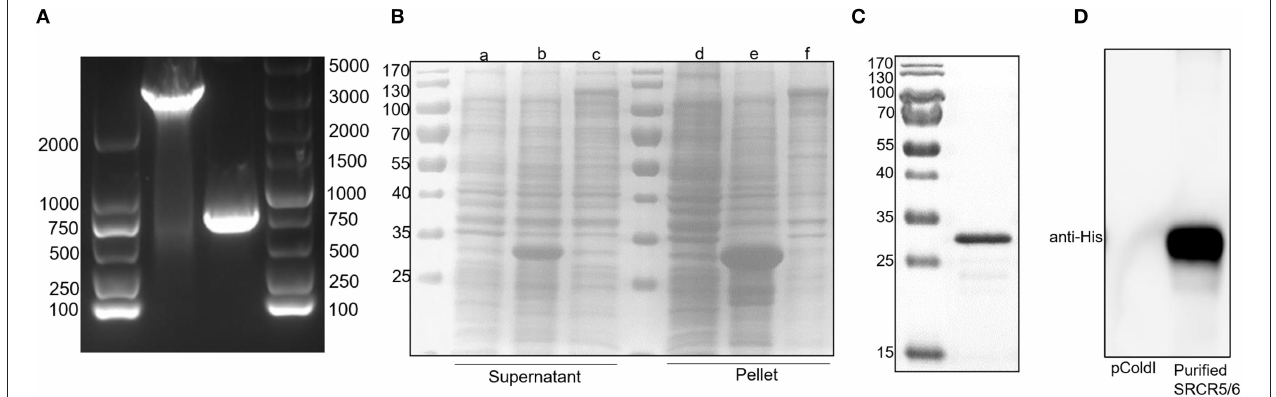
FIGURE 1 | Expression of His-tagged CD163 SRCR5-6 protein and its purification with SDS-PAGE. (A) Amplification of CD163 nucleotides 151-3348 and CD163 SRCR5-6. (B) Purification of pCold-I-SRCR5-6 with SDS-PAGE. Lanes a-c contain the supernatants of cells expressing pCold-I, pCold-I-SRCR5-6, and pCold-I-CD163, respectively, induced with IPTG, after ultrasonication. Lanes d-f contain the pellets of cells expressing pCold-I, pCold-I-SRCR5-6, and pCold-I-CD163, respectively, induced with IPTG, after ultrasonication. (C) Analysis of purified of His-tagged CD163 SRCR5-6 protein with SDS-PAGE. (D) Identification of purified His-tagged CD163 SRCR5-6 protein with western